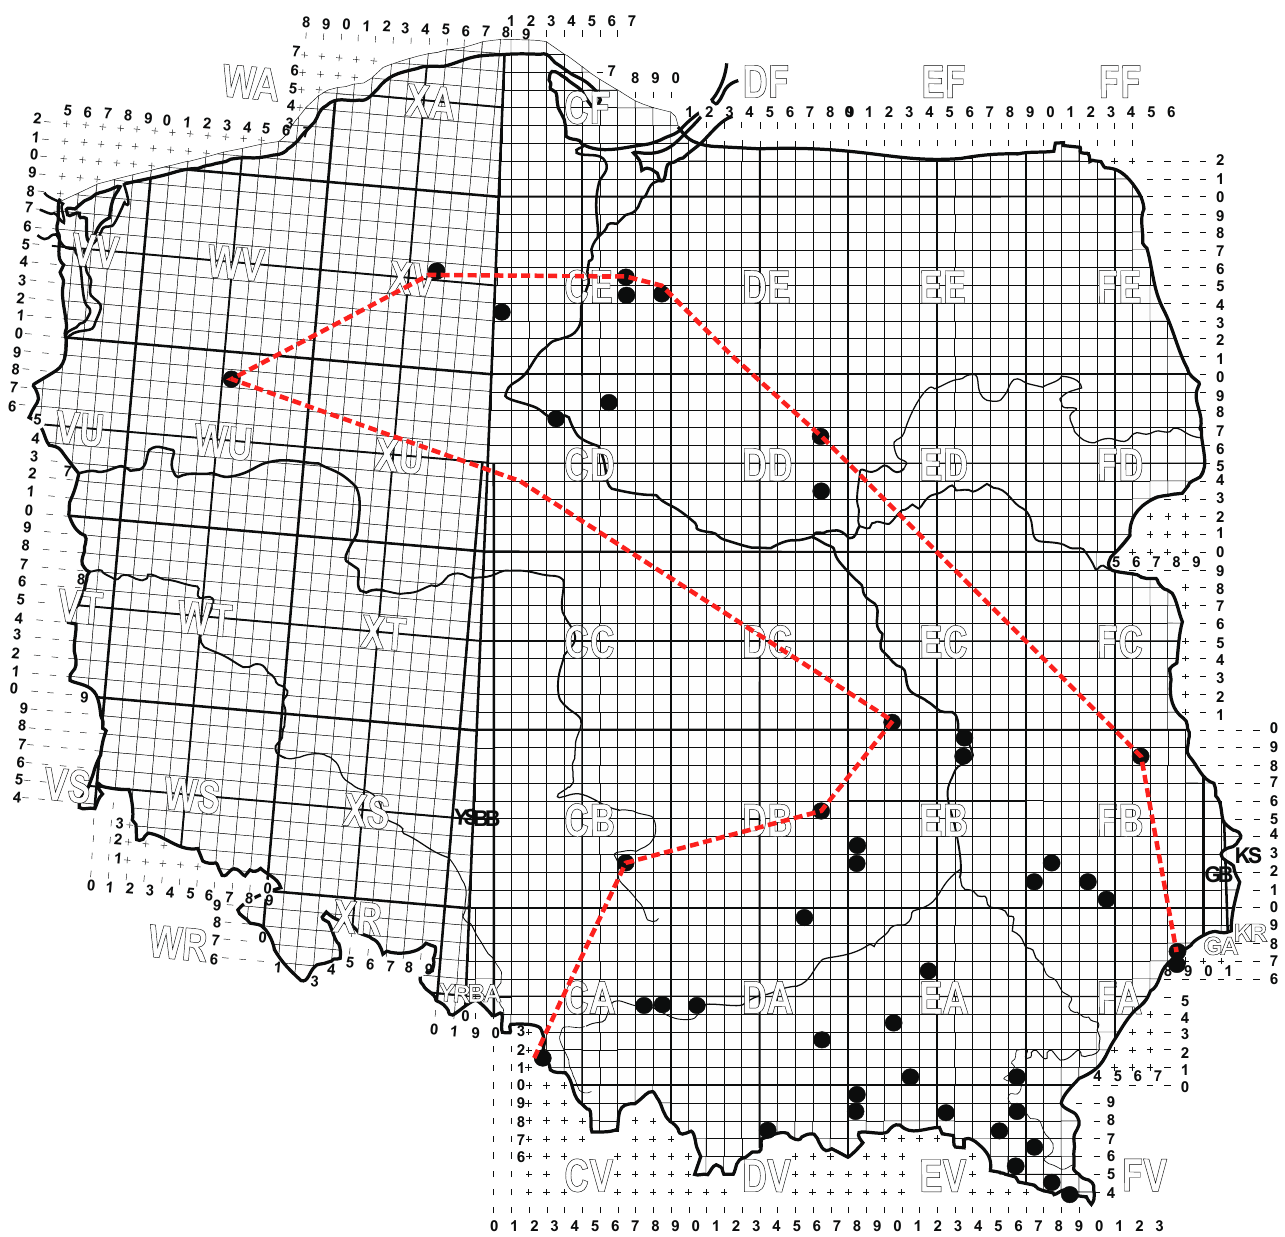
Figure 7. Geographical distribution of sites with Oodinychus obscurasimilis in Poland; the red dashed line marks the potential areas of occurrence of the species.